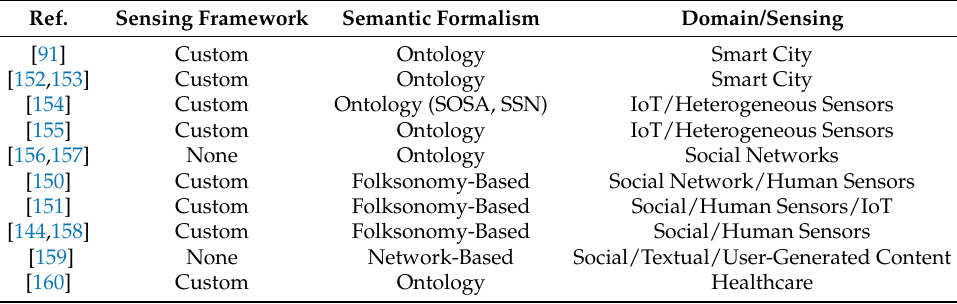
Table 3. Semantic Social Sensing and Social Network-Based